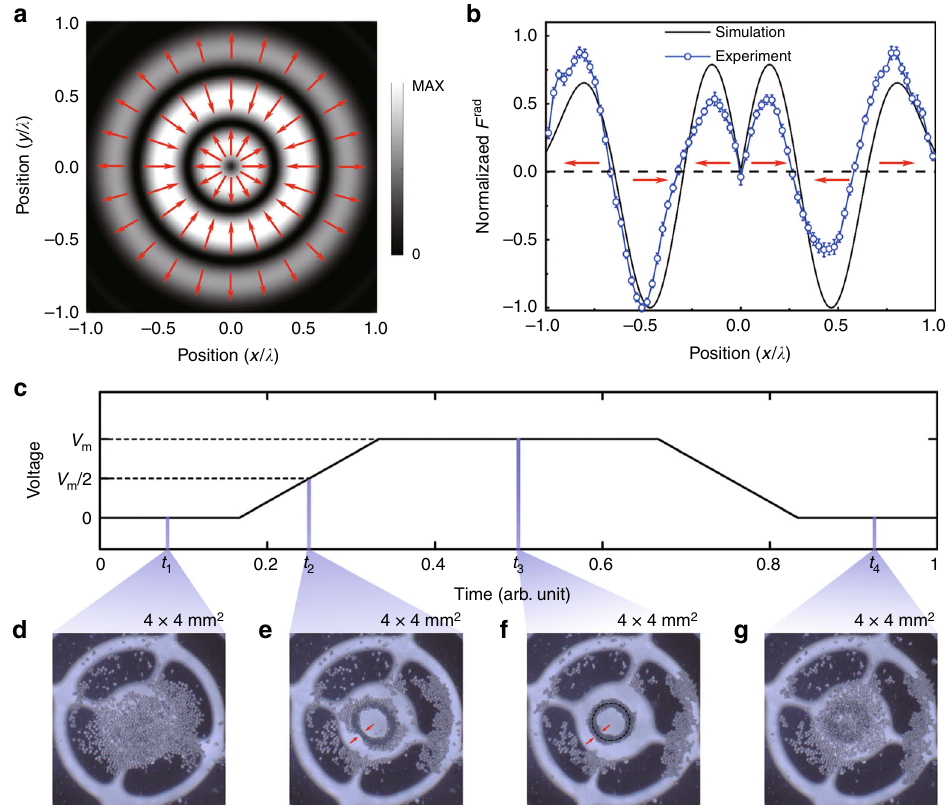
Fig. 4 Super-oscillation ultrasound tweezing. a The simulated radiation force distribution in the super-oscillatory fi eld. The force acts on polystyrene particles with the compressibility κ p ¼ 2 : 38 ´ 10 (cid:3) 10 Pa − 1 , the longitudinal wave velocity c p ¼ 2350 m s − 1 , the density ρ p ¼ 1050 kg m − 3 and the mean diameter a ¼ 100 μ m . b The simulated and measured radiation force distributions along the line x ¼ ½(cid:3) λ ; λ (cid:6) , y ¼ 0, z ¼ 5 : 2 λ . In a and b , directions of force vectors are marked by the red arrows. c The schematic voltage change with time. d – g The particle distributions at four different times, tha t is, t 1 , t 2 , t 3 , and t fi le of the diffraction-limit-broken spot in super-oscillation packets. The error bar is de fi ned 4 as marked in c . In f , the tightly trapped ring describes the pro by the standard deviation of normalized radiation force measured in ten